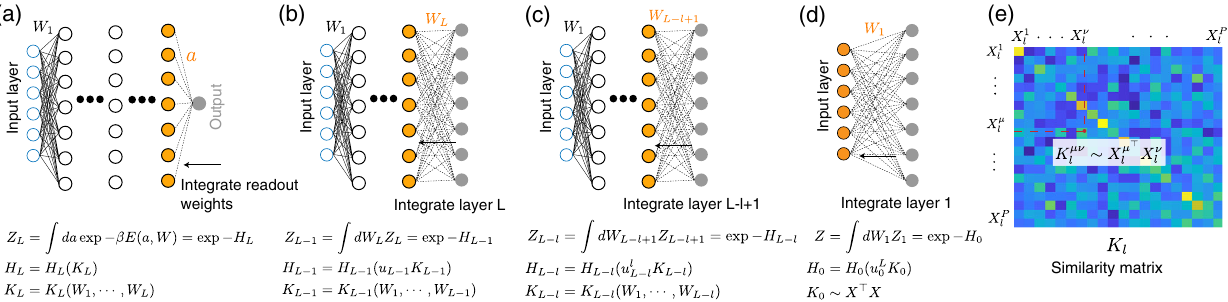
FIG. 1. Schematics of the backpropagating kernel renormalization. (a) Integrating out the readout weights of the network yields a partial partition function Z in the weight space with an effective Hamiltonian H , which is a function of all the hidden-layer weights L L through its dependence on the L th layer kernel matrix [see panel (e)] (with an additional L 2 regularization on the remaining weights neglected here). (b) Integrating out layer L yields a partial partition function Z in the remaining weight space with an effective L − 1 Hamiltonian H , which has the same structure as H except that the ( L − 1 )th layer kernel is multiplied by an order parameter u , a L − 1 L L − 1 scalar renormalization variable that summarizes the effect of the L th layer weights on the effective Hamiltonian. (c) Similarly, integrating out all weights downstream of layer L − l yields a partial partition function Z with an effective Hamiltonian with an order parameter L − l u , summarizing the effect of all l upstream integrated layers. (d) Integrating out all the weights in the network yields the total partition L − l function Z with the total free energy of the system H 0 with an order parameter u 0 , which depends only on the training inputs X μ ; μ ¼ 1 ; … ; P . (e) The l th layer kernel matrix is the similarity matrix of this layer ’ s responses to the P training inputs up to a normalization factor, and it is a function of all upstream